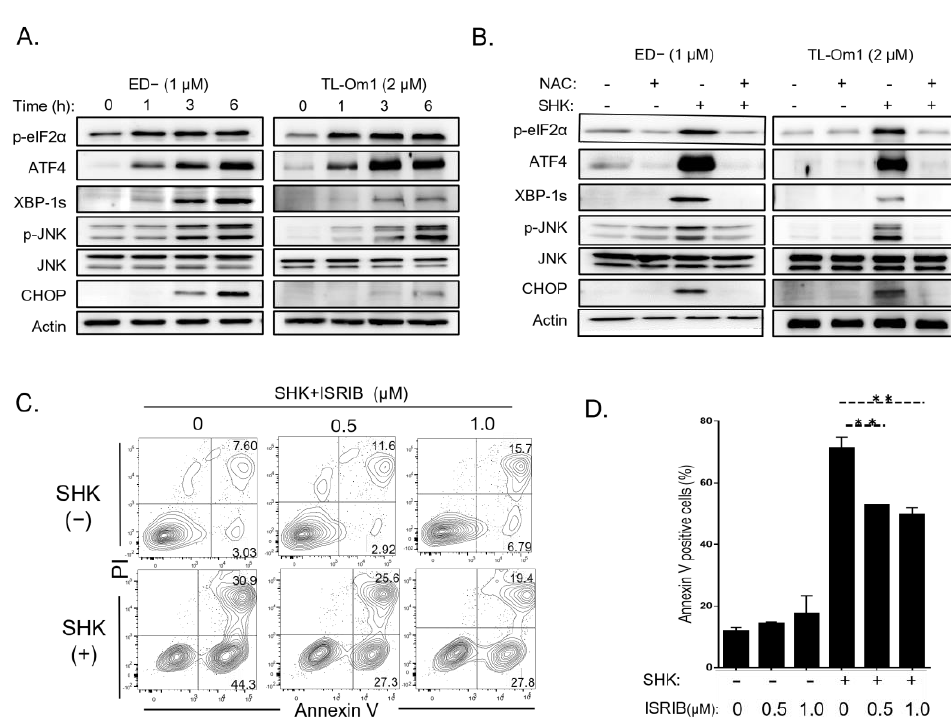
Figure 5. Induction of ER stress in ATLL cells through accumulation of ROS. ( A ) ED − and TL-Om1 cells treated with or without SHK for 0–6 h with 1 and 2 µ M for ED − and TL-Om1, respectively. Activation of ER stress markers was determined by Western blotting. ( B ) Human ED − and TL-Om1 cells were pre-treated with/without NAC for 2 h, and then treated with or without SHK for 6 h. Activation of ER stress markers was determined by Western blotting. ( C , D ). ED − cells were pre- treated with ISRIB for 1 hr and treated with 1 µ M of SHK for 12 h. Cells were harvested and stained with Annex-n V and PI, and analyzed with flow cytometry. **p<0.01.